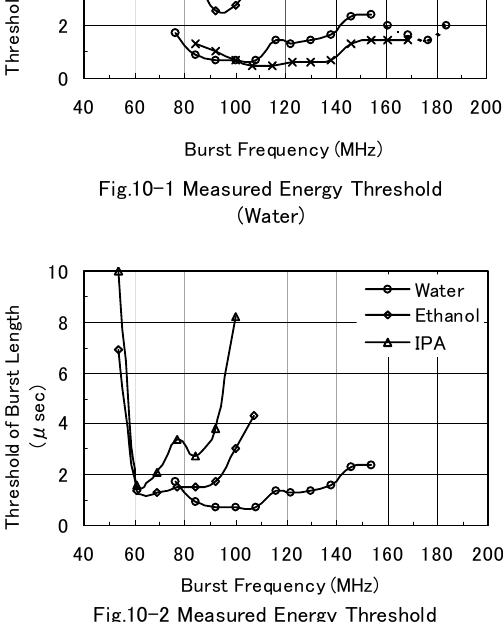
Fig.10-2 Measured Energy